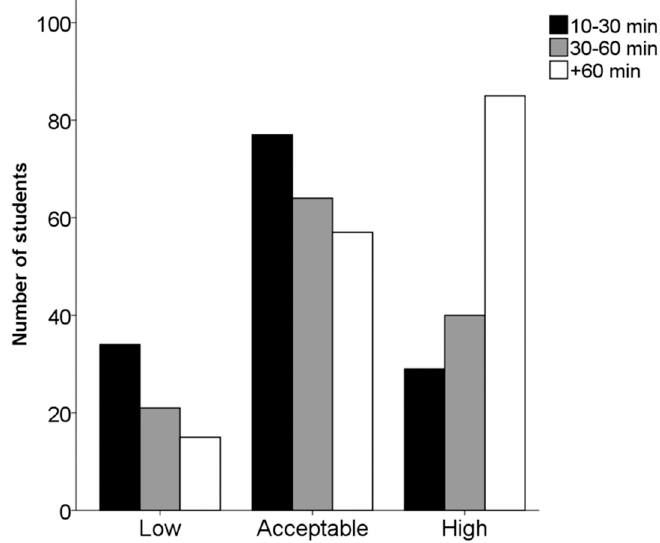
Figure 1. Relation between perceived health perception and duration of exercise sessions. No associations were established between any of the variables and the choice of weekends or weekdays as the timetable for